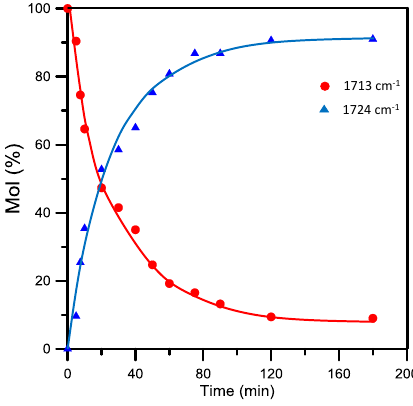
Figure 8. Deconvoluted IR absorbance peaks in the carbonyl-stretching region for phenoxy/PBT (9/1) after isothermal treatment at 260 °C for various periods of time: ( a ) 5 min, ( b ) 20 min, and ( c ) 90 min.